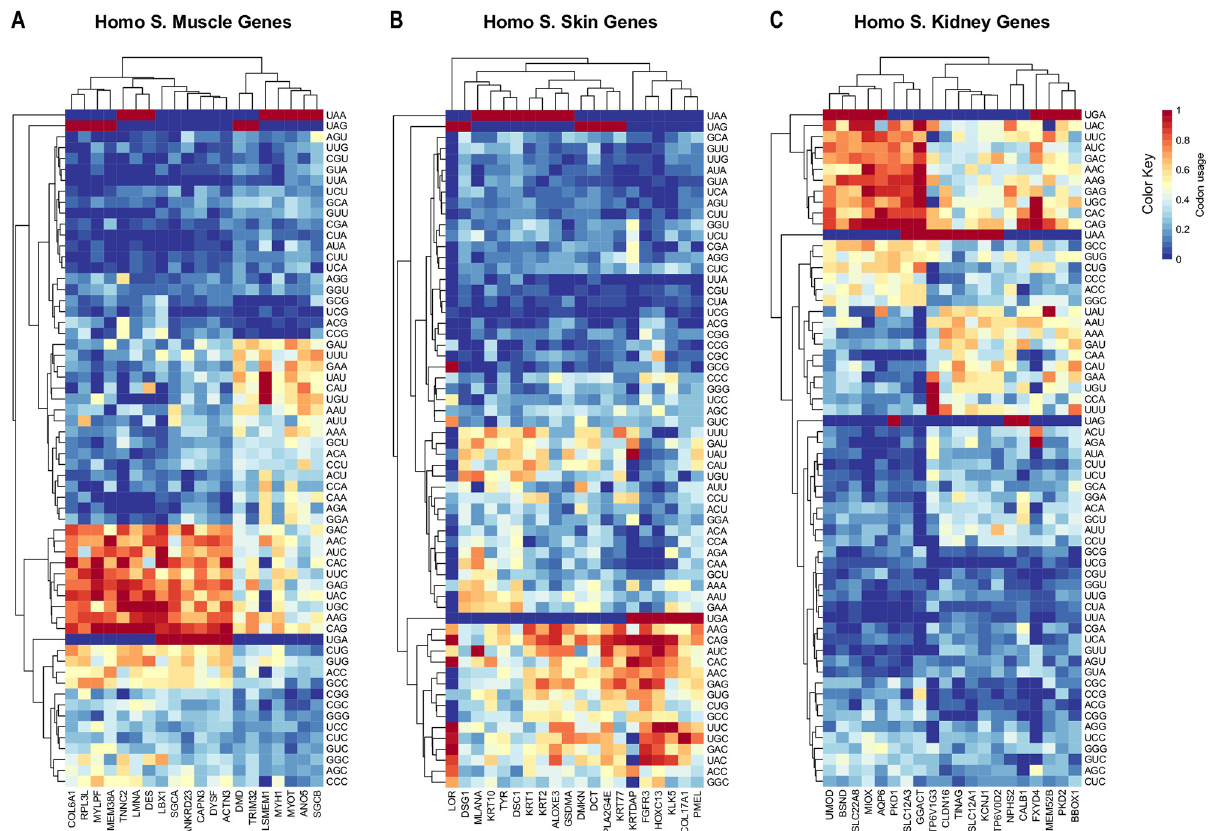
Fig 1. CU values in Homo sapiens muscle, skin, and kidney genes. Heat plots were generated using R package gplots. Rows were clustered based on Euclidean distance. The color coding varies from dark blue to red with low to high CU values, respectively. Hierarchical clustering of synonymous codon usage in all studied genes in different tissues (muscle, skin and kidney) in HSA was generated. The heat plot graphs show that the clustering of frequently used codons (in red) and rarely used codons (dark blue) greatly varies among genes and tissues. In muscle genes, extremely biased codons (low CU values, key color dark blue, or high CU values, key color dark red) are tightly clustered in terms of both gene and codon types, while intermediate CU values (key color light blue to yellow) are more dispersed in the trees (panel A). Among muscle genes, only DMD does not show any extreme CUB, since no red spots (corresponding to higher CU values) occur (Fig 1A). The CUB fingerprint of skin genes (panel B) shows a prevalent low CU values codons (dark blue), with a few dispersed, not clustered, inhomogeneous distributed yellow-red spots (intermediate and high CU values). CU clusters are less defined compared to muscle. In kidney genes (panel C), the CUB fingerprint also differs from the other two gene groups. The vast majority of genes have low or intermediate CU values (wide and diffuse yellow-blue spot clusters) with a cluster of high CU values closely clustered and related to UMOD, BSND, SLC22A8, MIOX, AQP6, PKD1, SLC12A3, and GGACT genes. Interestingly all of these genes are